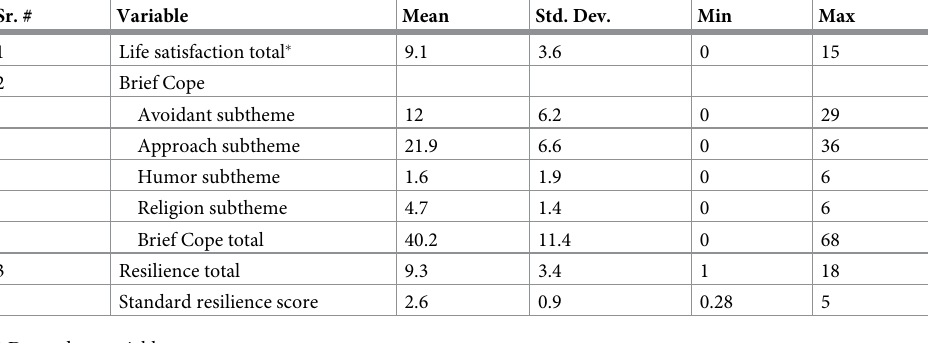
Table 2. Means scores of the life satisfaction, resilience, and coping orientations.